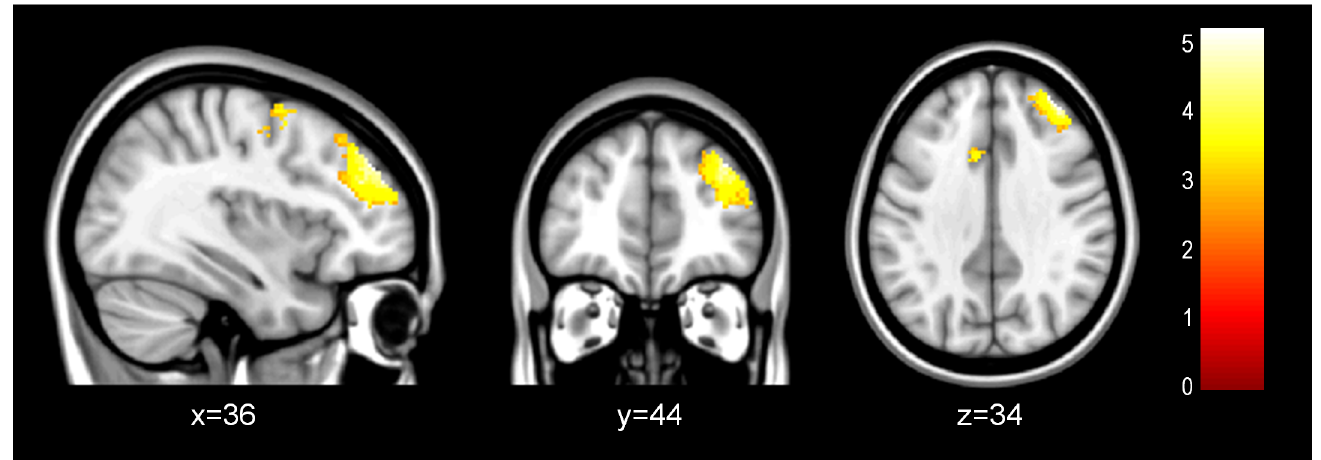
Fig 4. PPI Results. Regions showing different patterns of connectivity with the right insula seed between normal-weight individuals compared to excess- weight participants during reappraisal (Regulate > Maintain), with normal-weight subjects presenting a significant anticorrelation between the right insula and the PFC regions